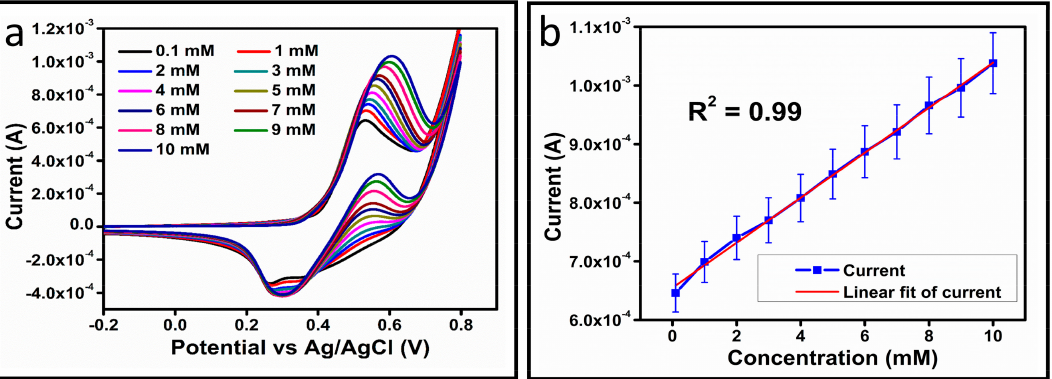
Figure 4. ( a ) CV curves of Sample 2 based on NiCo 2 O 4 nanomaterial, at 50 mV/s in the presence of various urea concentrations prepared in 0.1 M NaOH, ( b ) Linear plot of oxidation peak current versus different urea concentrations.